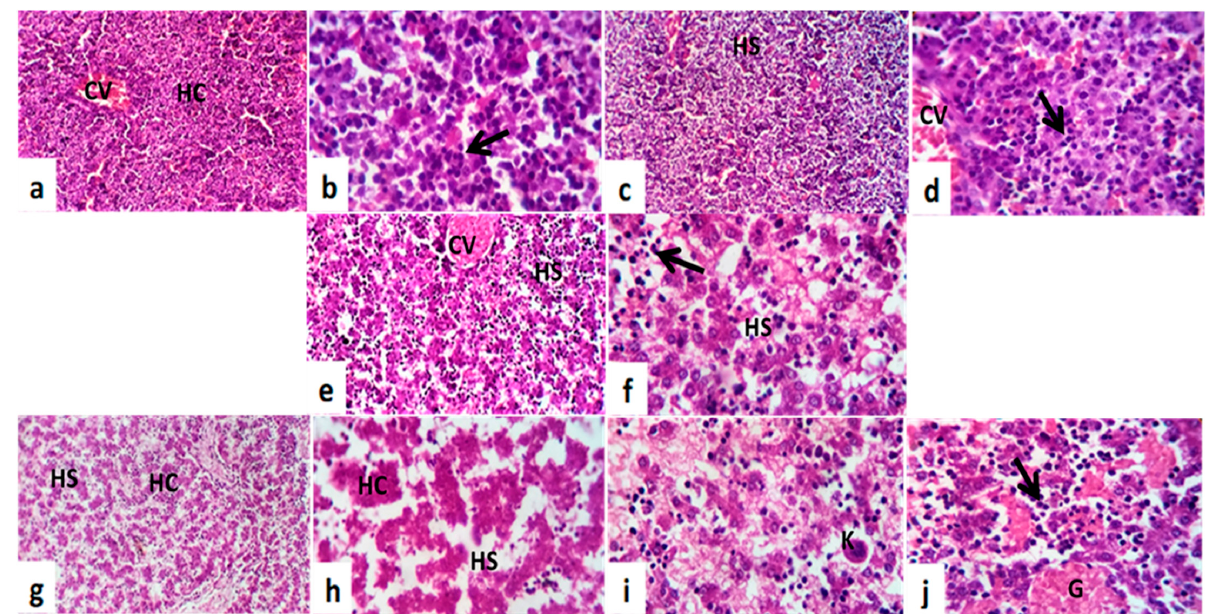
Figure 9. Photomicrographs of fetal liver tissue sections of metronidazole-maternally treated mice. ( a , b ) Normal control group, ( c , d ) treated female at (0–7th dpc), ( e , f ) treated female at (7th–14th dpc), and ( g – j ) treated female at (0–20th dpc). Notice the central vein (CV), hepatic cords (HC), hepatic sinusoids (HS), circulate nucleated erythrocytes, mature hemopoietic cells (arrows), megakaryo- cytes (K), and hemorrhage (G). H&E. (a, c, e, g = Scale 100 µm) (b, d, f, h, i, j = Scale 50 µm).